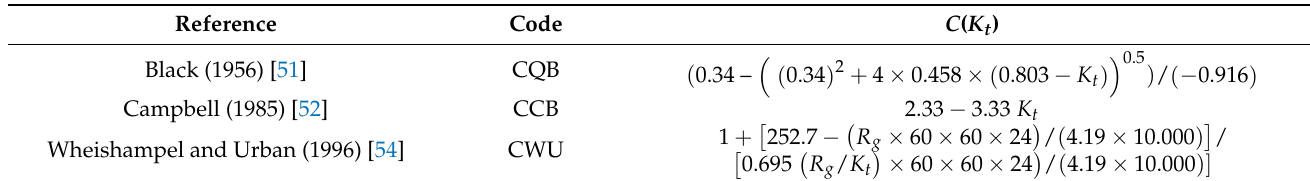
Table 2. Equations for sky cover fraction function C ( K t